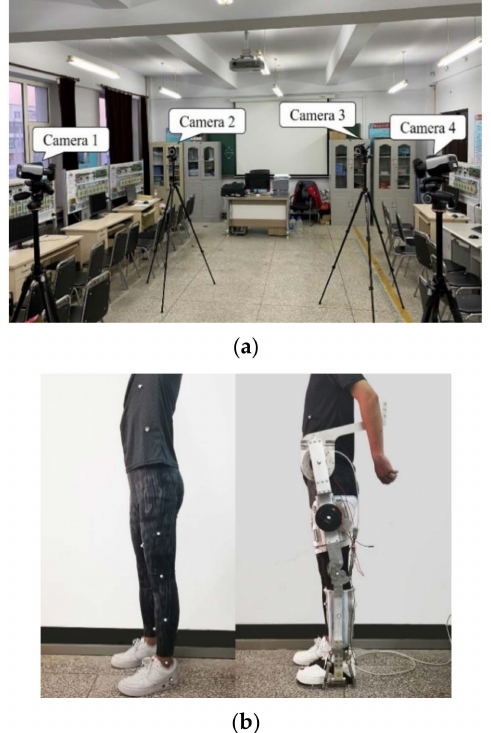
Figure 18. Acquisition diagram of dynamic capture system: ( a ) Human motion capture scene; ( b ) Paste position of human motion markers.